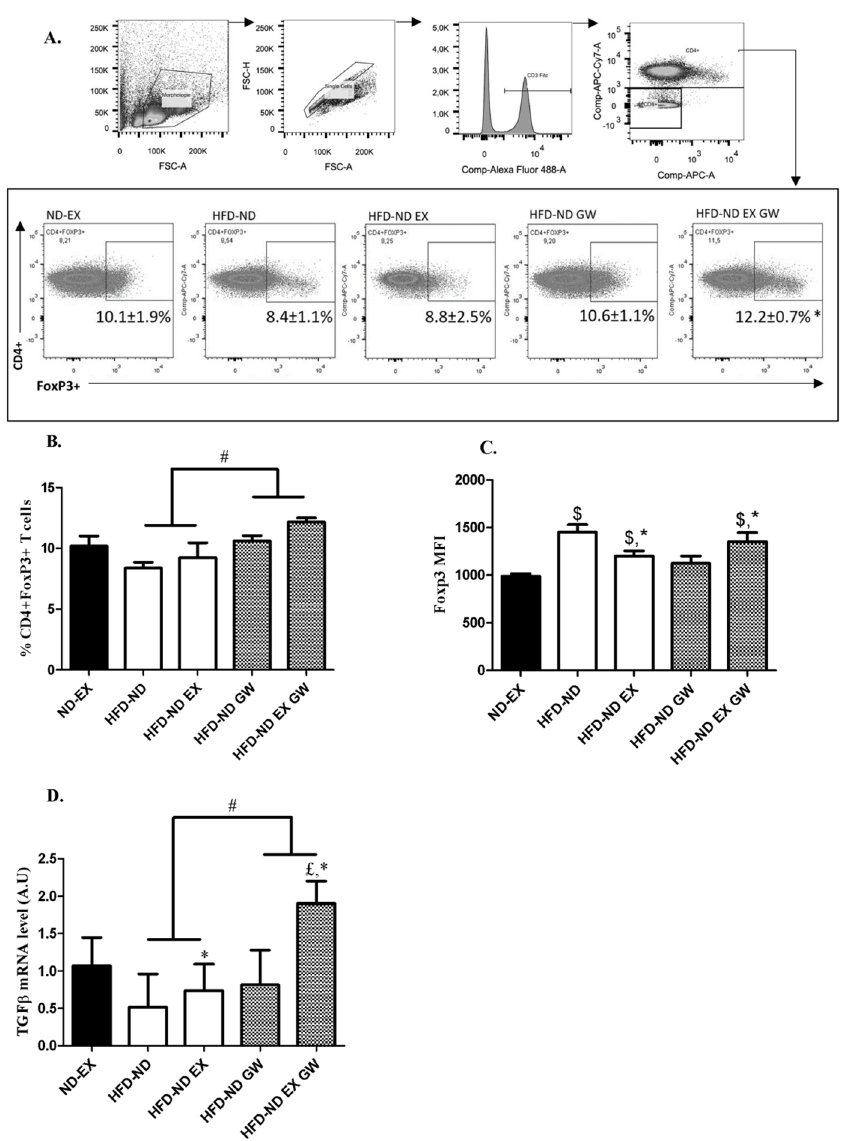
Figure 4. CD4 + expressing Foxp3 T cells in lymph nodes and TGF- β mRNA levels. ( A ) Gating strategy of flow cytometry analysis of Foxp3 + on CD4 + cells from lymph nodes. ( B ) Frequency of CD3 + CD4 + Foxp3 + T cells from lymph nodes after return to ND (T1). ( C ) Mean Fluorescence Intensity (MFI) in the APC fluorescence channel (gated Foxp3 + in A ). ( D ) mRNA levels of TGF- β relative to 36B4 in lymph nodes. Data are shown as mean ± SD ( n = 6 per group). # p < 0.05, GW0742 e ff ect and * p < 0.05, interaction e ff ect between exercise and GW0742 (2-way ANOVAs). $ p < 0.05 vs. ND-EX and £ p < 0.05 vs. all groups (one-way